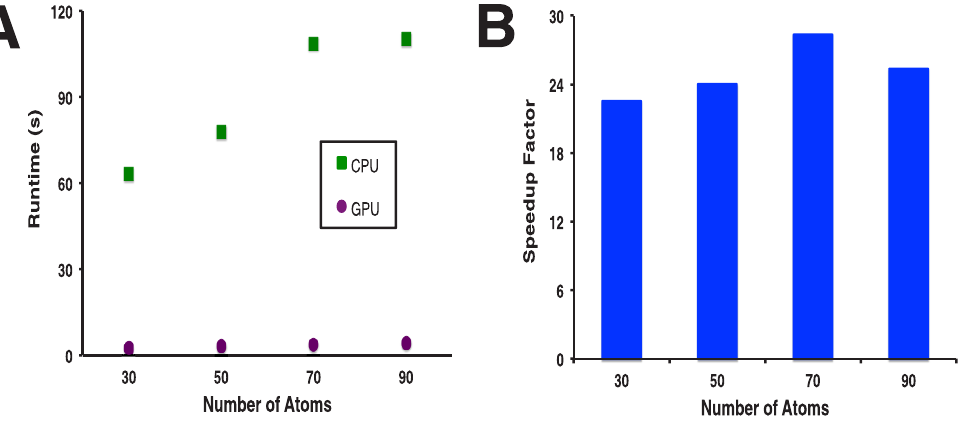
Figure 6. Dependence on number of atoms in the ligand. Ligands of varying sizes were docked using DARC. A ) Time required to complete the optimization, using a CPU alone or with the GPU. B ) Speedup factor, reported as the ratio of the time required using the GPU to the time required using the CPU alone.